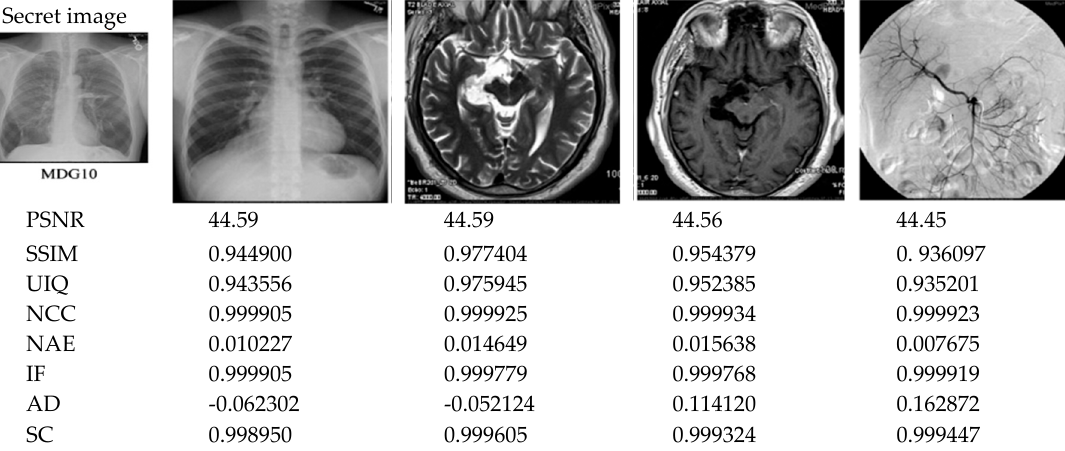
Figure 11. Graphical representation of performance analysis of the proposed steganography scheme where the secret medical image (MDG05) is embedded onto the remaining cover colour medical images presented earlier in Figure 3 (i.e., those labelled MDG01 through MDG04).